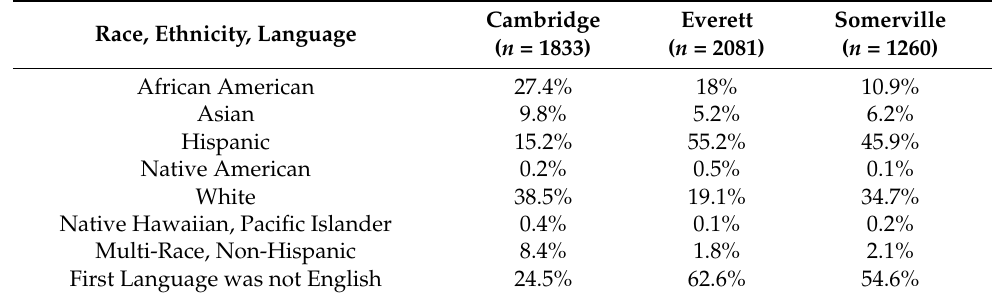
Table 1. Racial, ethnic, and linguistic demographic information for the students at the three public high schools with